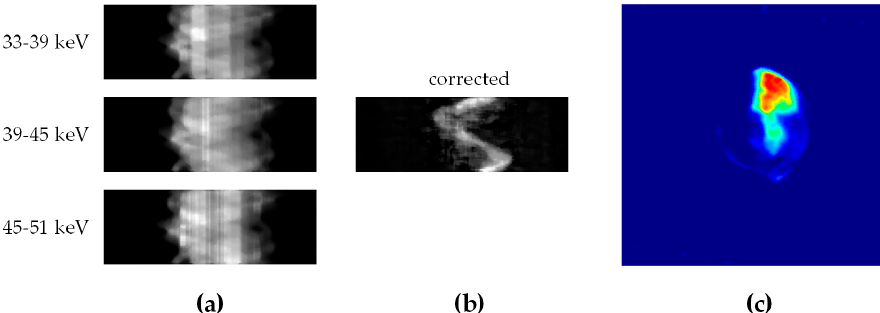
Figure 8. Schematic representation of data acquisition and image reconstruction procedure: ( a ) Raw data recorded by three energy bins; ( b ) projection data after scatter correction and ( c ) the reconstructed XFCT image.